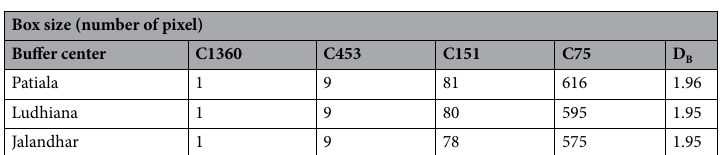
Table 4. Fractal dimension (DB) using box counting method in the three large buffers around the XL settlements of Ludhiana, Jalandhar, and Patiala in the N-Indian Punjab.